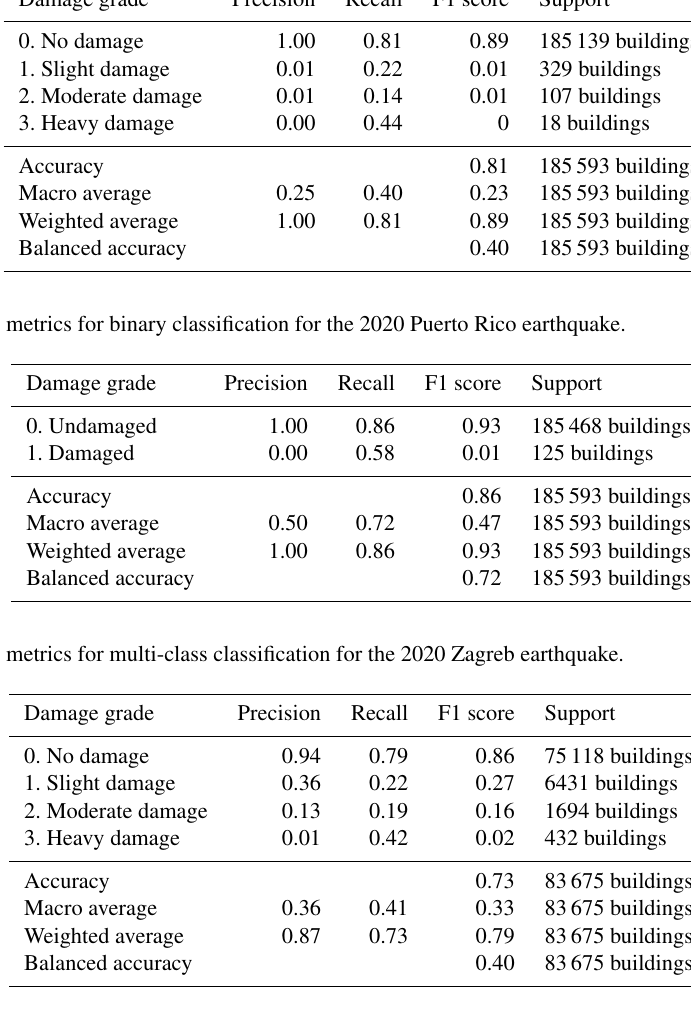
Table 6. Test-set performance metrics for multi-class classification for the 2020 Puerto Rico earthquake. Damage grade